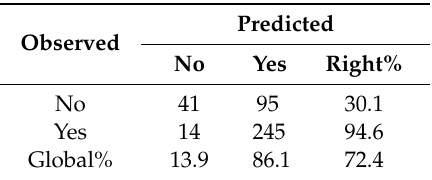
Table 2. Classification success for using Table 3. Earnings for nodes: target those who do use YouTube.